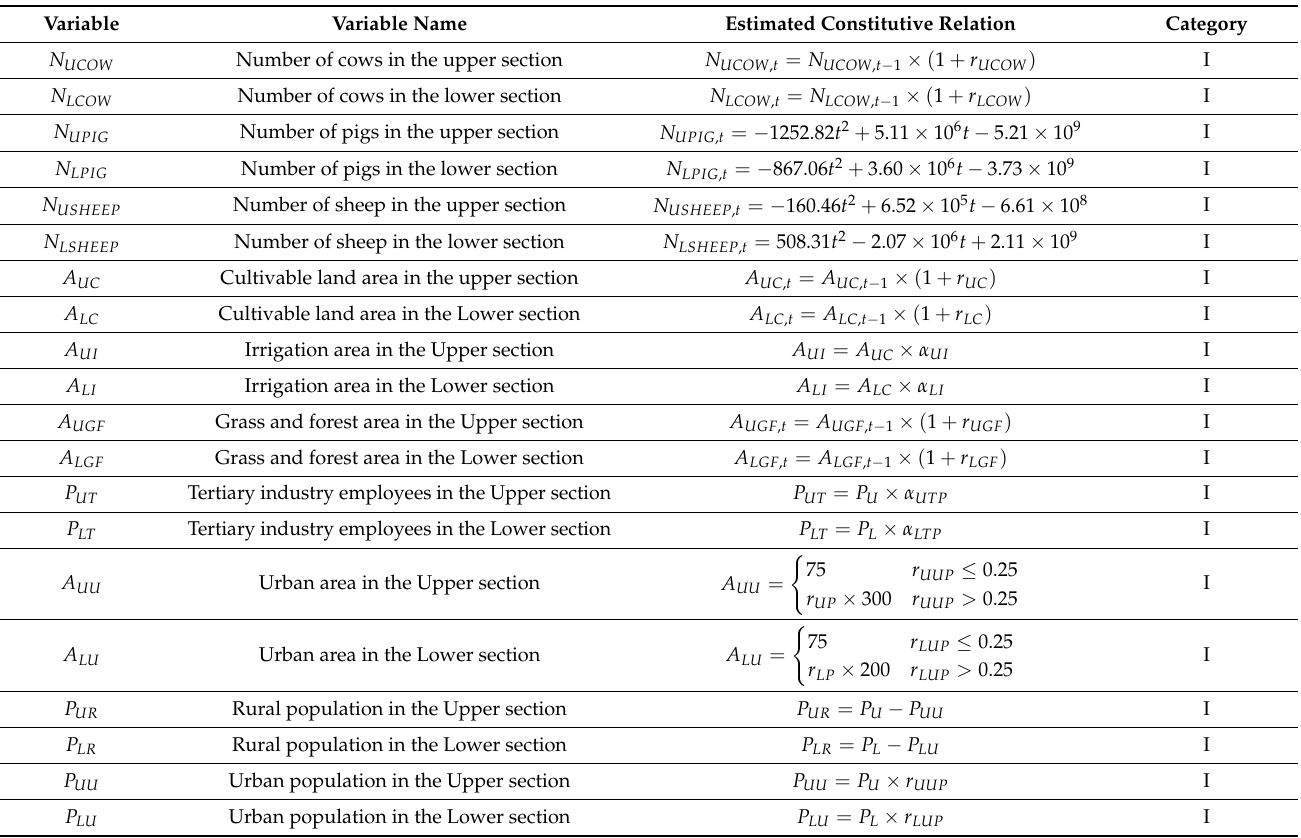
Table A2. The constitutive equations of Class I.